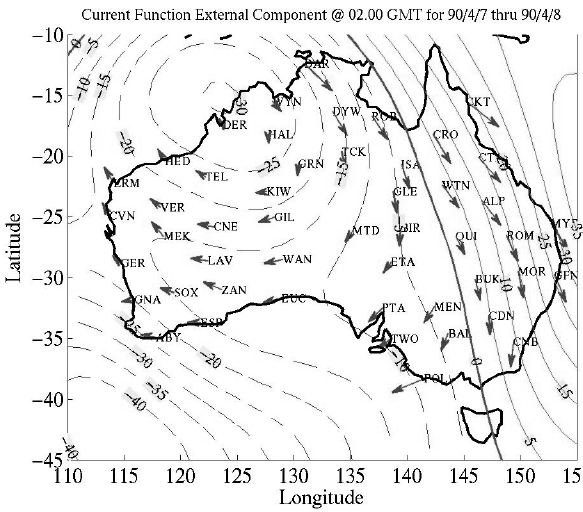
Fig 7. Current system at 2.3 h UT on 8 April, 1990, as for Fig 3. Fig. 7. Current system at 2.3h UT on 8 April, 1990, as for Fig. 3.